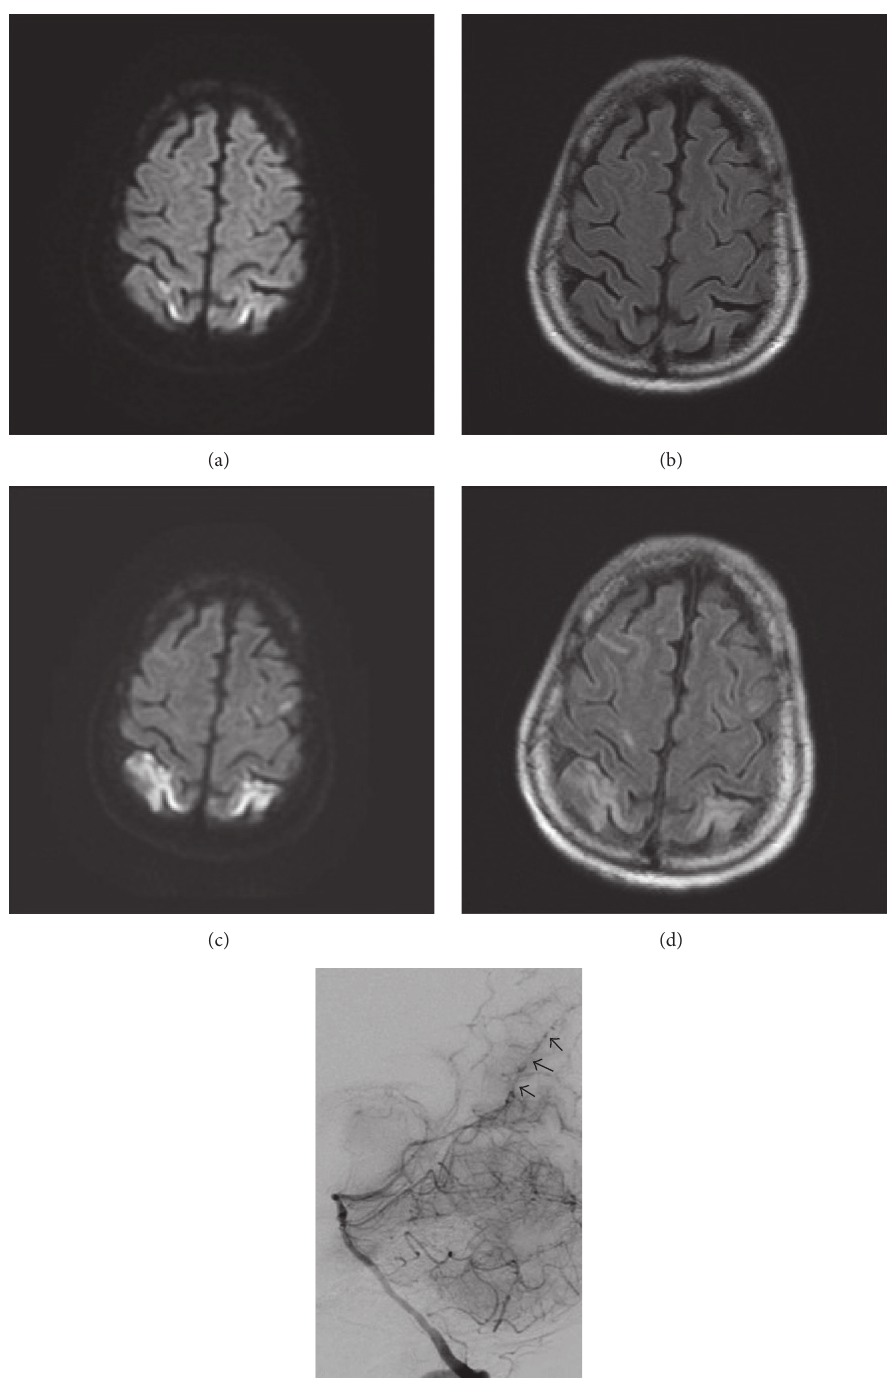
Figure 1: Relevant brain and blood vessel imaging highlighting vasculitic cause of multifocal strokes. MRI on day of admission with diffusion scan (a) significant for curvilinear increased signal in the cortical surface of both anterior parietal lobes extending into the postcentral gyrus on left, with additional foci of restricted diffusion within the periventricular white matter in both hemispheres (left > right). Subtle signal abnormalities are seen along cortical surface primarily in both anterior parietal lobes on FLAIR imaging (b). MRI performed 2 days after initial imaging showed progression of FLAIR signal (d) abnormalities with reduced diffusion (c) consistent with multifocal cortical infarcts involving the posterior frontal, occipital, left temporal, left frontal, and deep bilateral white matter. Cerebral angiogram (e) showing multifocal distal small vessel moderate to severe vasculitis predominantly involving the posterior circulation. Arrows point to areas of vessel beading and